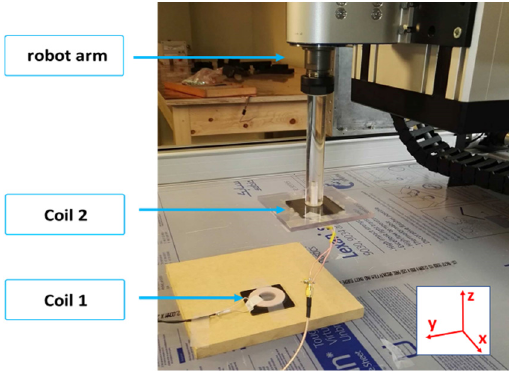
Figure 21. Used test bench.